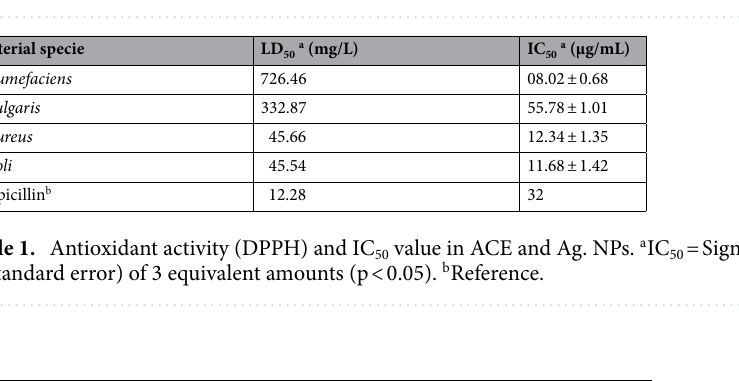
Figure 10. Antibacterial activity of the ACE and Ag. NPs of Plantago lanceolata LD 50 is concentration causing 50% inhibition .